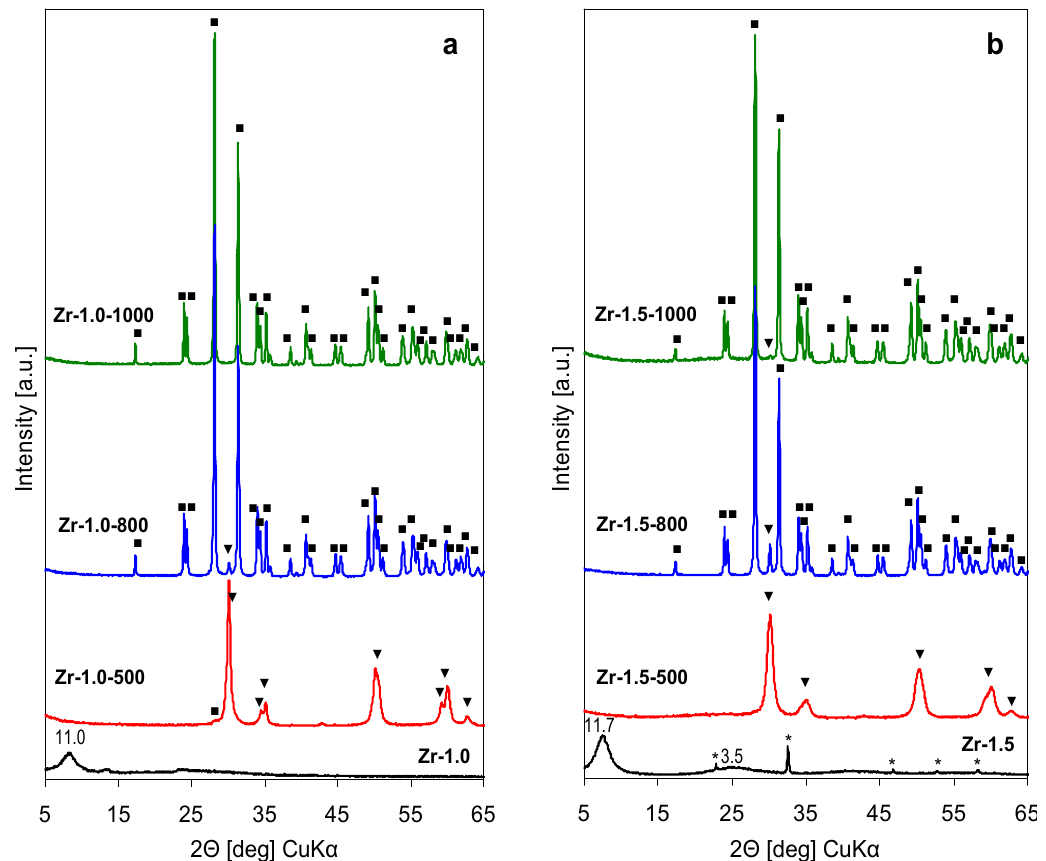
Figure 4. XRD patterns illustrating the effect of thermal treatment on hydrolysates obtained by lyophilization of Zr- pillaring solution: ( a ) As received at pH = 1.0, ( b ) after pH adjustment to 1.5 ( ▼ t -ZrO 2 , ■ m -ZrO 2 , * NH 4 Cl).